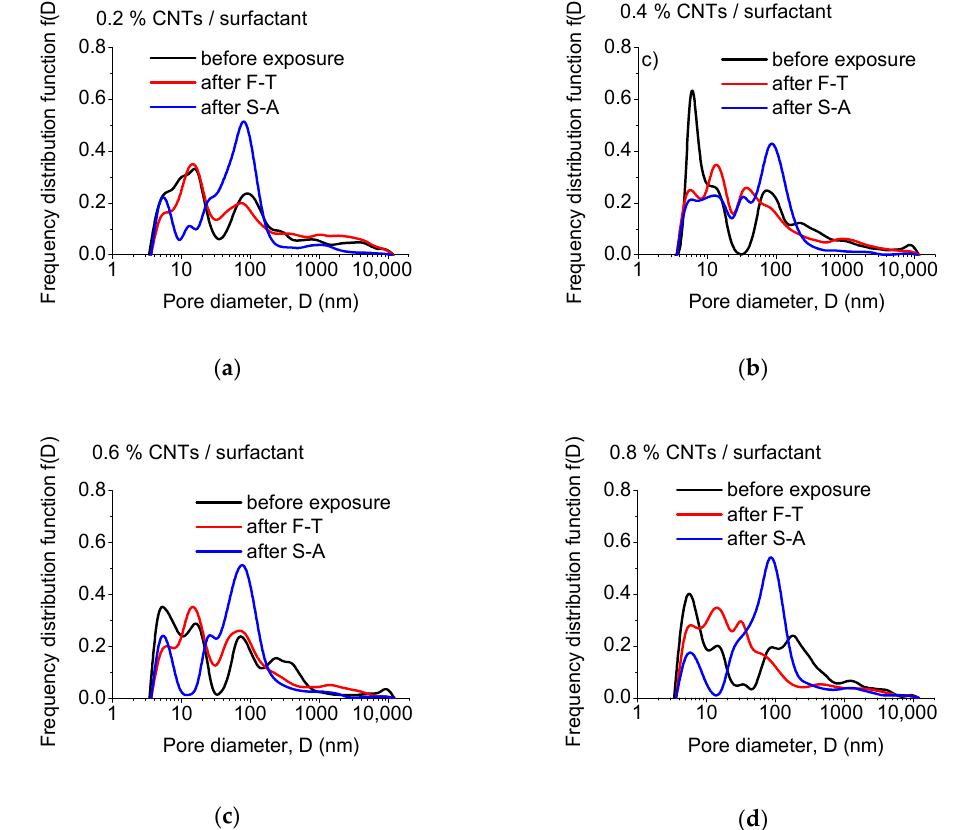
Figure 6. E ff ect of exposure state on the pore size distribution of mortars with: ( a ) 0.2, ( b ) 0.4, ( c ) 0.6, and ( d ) 0.8 wt.% CNT contents, prepared using surfactant as dispersant.